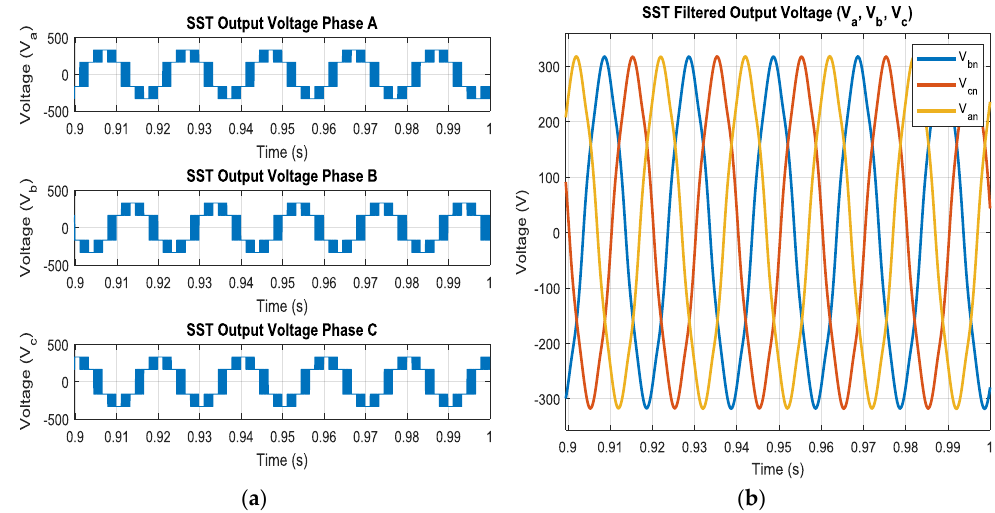
Figure 13. ( a ) SST-VSI output voltage without filter. ( b ) Filtered SST output voltage.